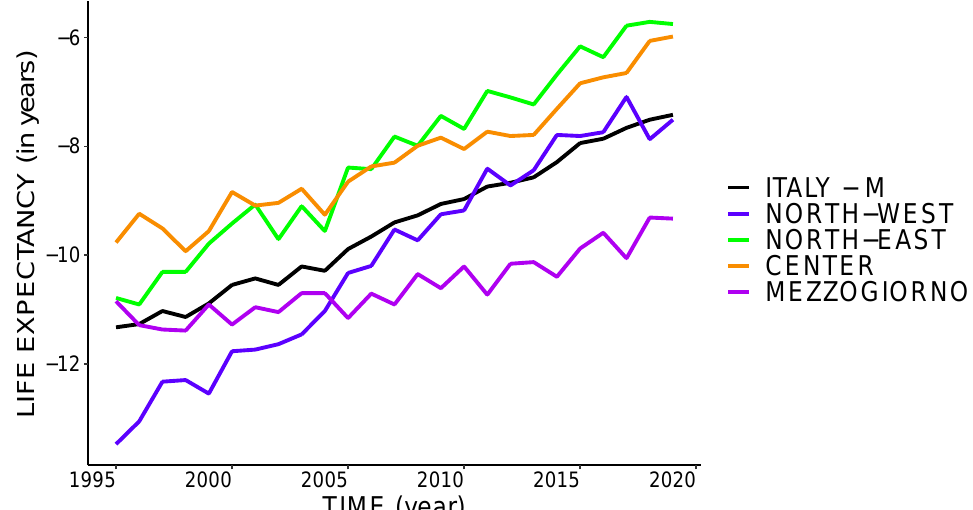
Figure 6. Tax/Subsidy rates for Italian female ( top ) and male ( bottom ) population aged 65 from 1995 to 2019 across macroareas (NUTS-1). Source: author’s own elaboration on data from ISTAT.